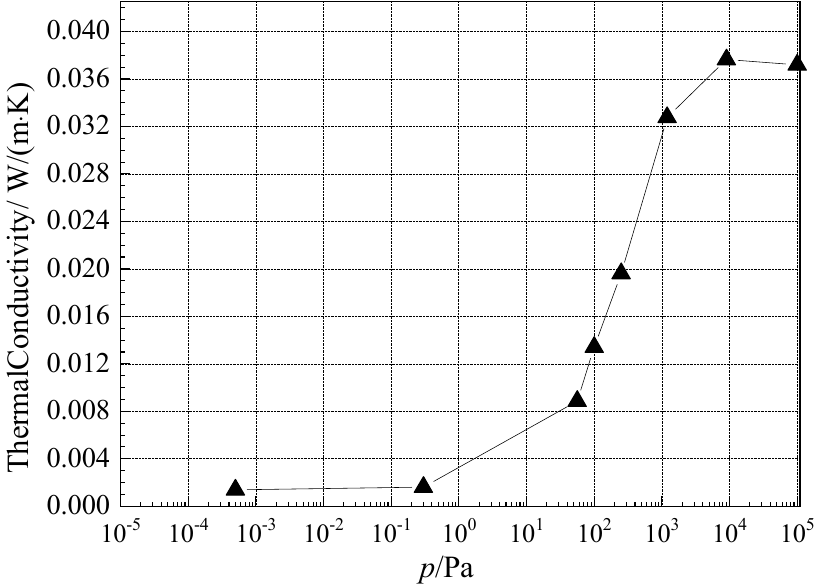
Figure 8. Thermal conductivity of new insulation materials at different vacuum levels; temperature, 40 °C.